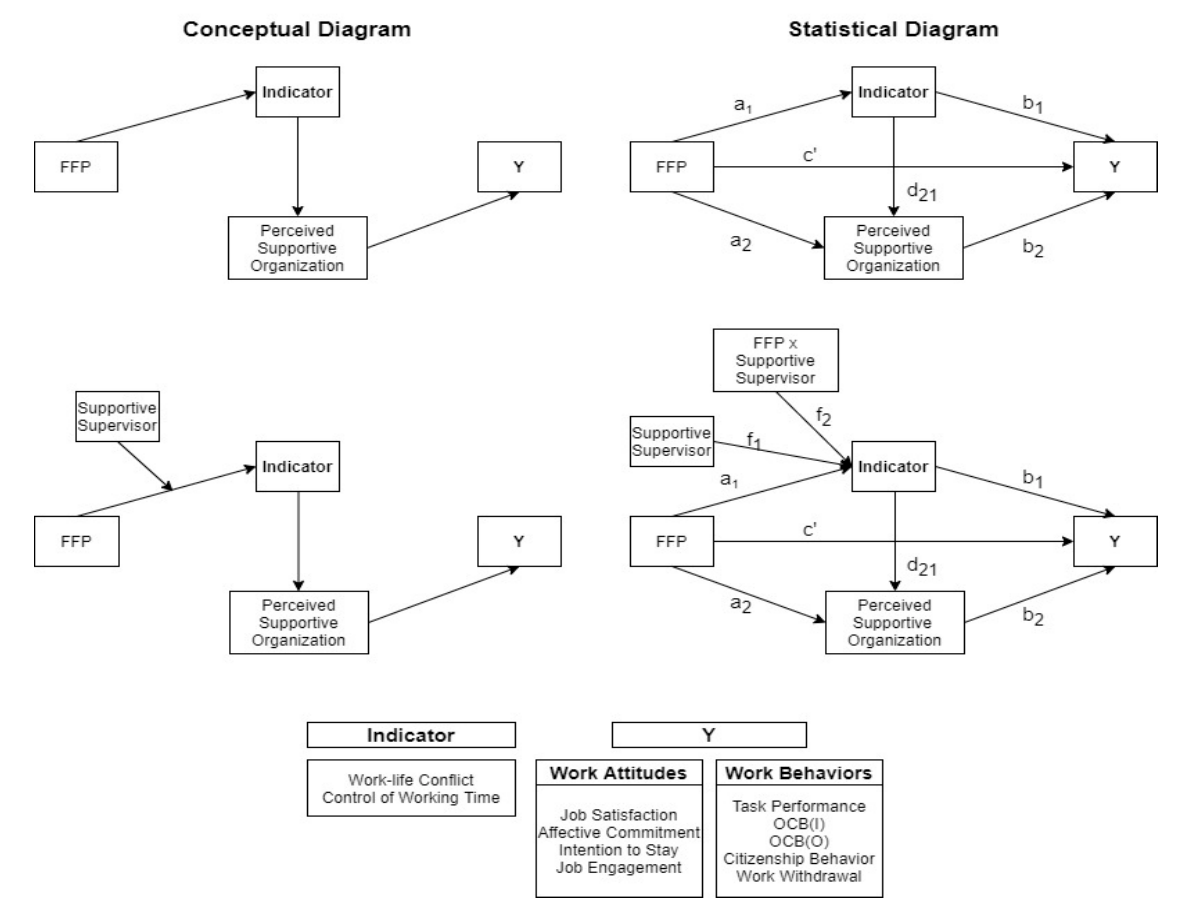
Figure 1. Conceptual and statistical diagrams for analysis of family-friendly policy and supervisor support on various outcomes through serial mediation pathways.